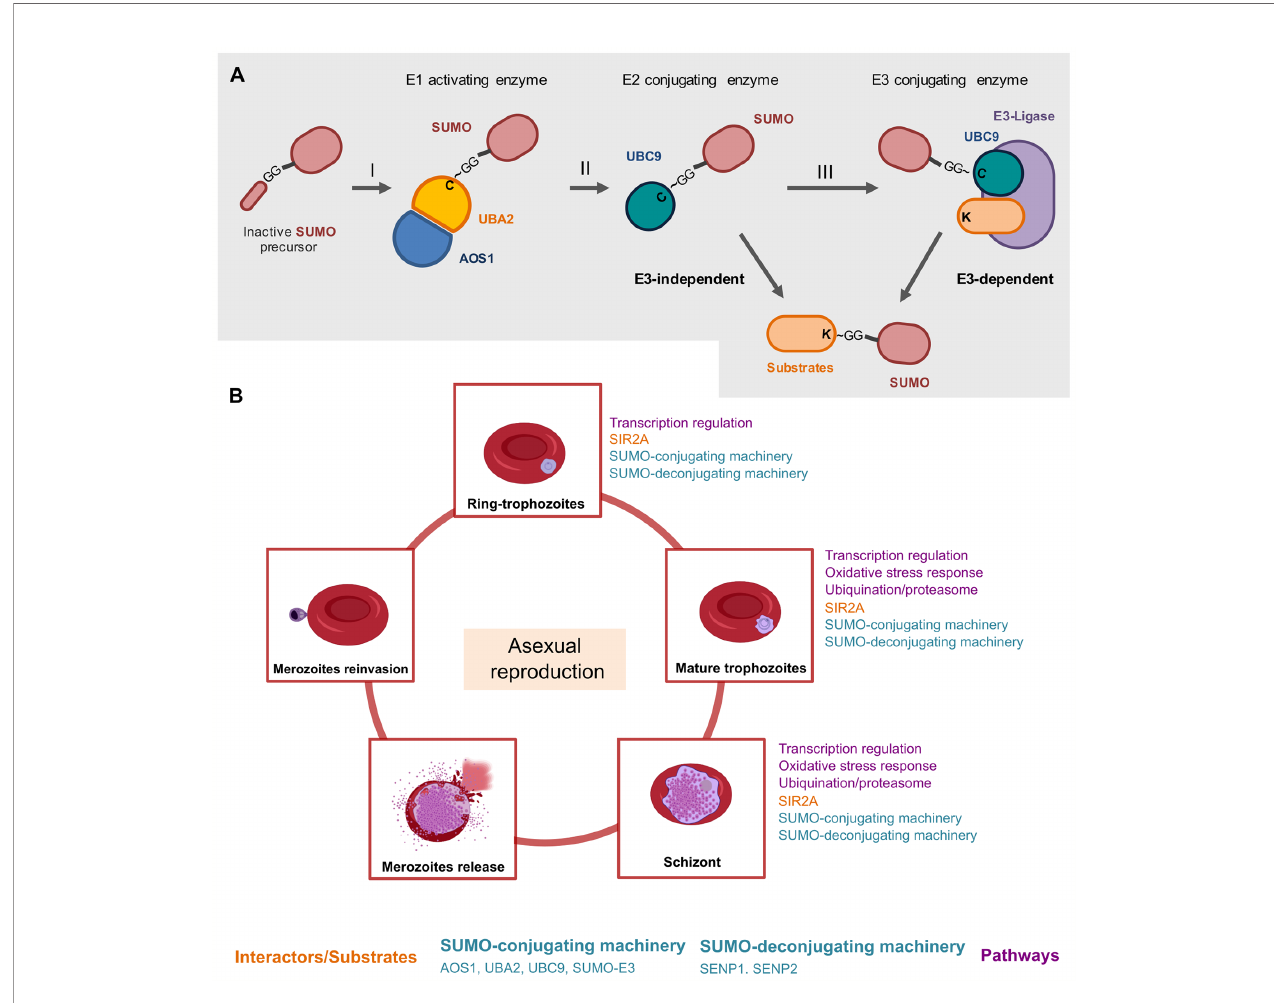
FIGURE 1 | A schematic overview of the roles of the SUMO machinery throughout the intraerythrocytic life cycle of Plasmodium in the human host. (A) Before the fi rst conjugation, SUMO is processed proteolytically by exposing its di-glycine motif at the C-terminal. SUMO in its mature state is activated by the heterodimeric enzyme E1 (AOS1-UBA2) in an ATP-dependent reaction, carried out by the AOS1 portion, which results in a thioester bond between the di-Glycine residue and catalytic cysteine in UBA2 (I). SUMO is then transferred to the catalytic residue of the enzyme E2 UBC9 (II). Finally, an isopeptide bond is formed between the Gly C-terminal residue of SUMO and a lysine residue on the substrate, generally supported by an E3 ligase (III) (Reverter and Lima, 2004). The SUMO deconjugation is catalyzed by speci fi c isopeptidases/proteases that cleave the isopeptide bond between the SUMO C-terminal glycine and the lysine chain in the target proteins, restoring the mature SUMO for another cycle of conjugation (Ponder et al., 2011). (B) The roles of the SUMO machinery during asexual replication in erythrocytes. During asexual replication, merozoites infect erythrocytes and become intracellular ring forms, trophozoites, and schizonts that disrupt erythrocytes. The released merozoites can then infect new erythrocytes (Absalon et al., 2018). The so far explored molecular pathways which involves Pf SUMO, are transcriptional regulation (Tonkin et al., 2009; Absalon et al., 2018), oxidative stress response (Reiter et al., 2016) and ubiquitination/proteasome (Ponts et al., 2011) as presented in Figure 1